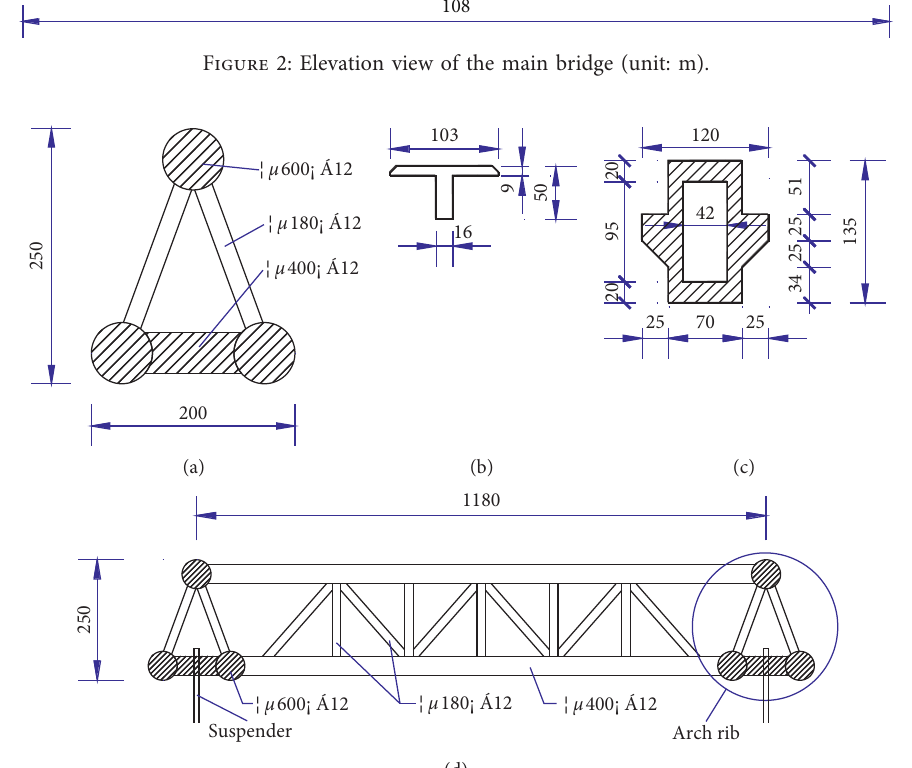
Figure 3: Component drawings (unit: cm): (a) arch rib; (b) longitudinal beam; (c) transverse beam; and (d) details of wind